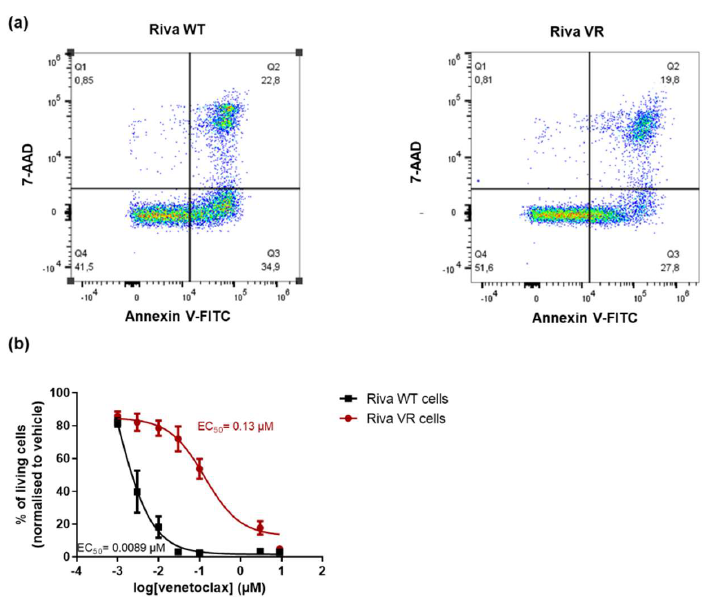
Figure 1. Riva VR cells are resistant to venetoclax as compared to Riva WT cells. ( a ) Representative dot plots from flow cytometric analysis of AnnexinV-FITC / 7-AAD stained Riva wild-type (WT) and venetoclax-resistant (VR) cells, treated with venetoclax at 3 nM and 100 nM, respectively, during 24 h. ( b ) Dose–response curves of Riva WT and Riva VR 24 h after drug exposure. The apoptotic population was defined as the AnnexinV-FITC-positive fraction. Data presented are average ± SEM (n = 5).